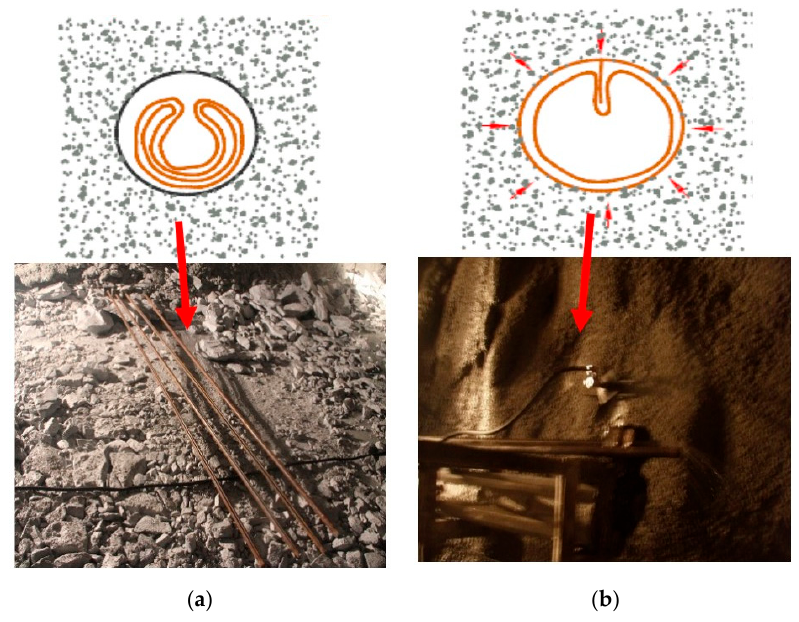
Figure 15. Water swelling anchor: ( a ) Samples and ( b ) pressurization.